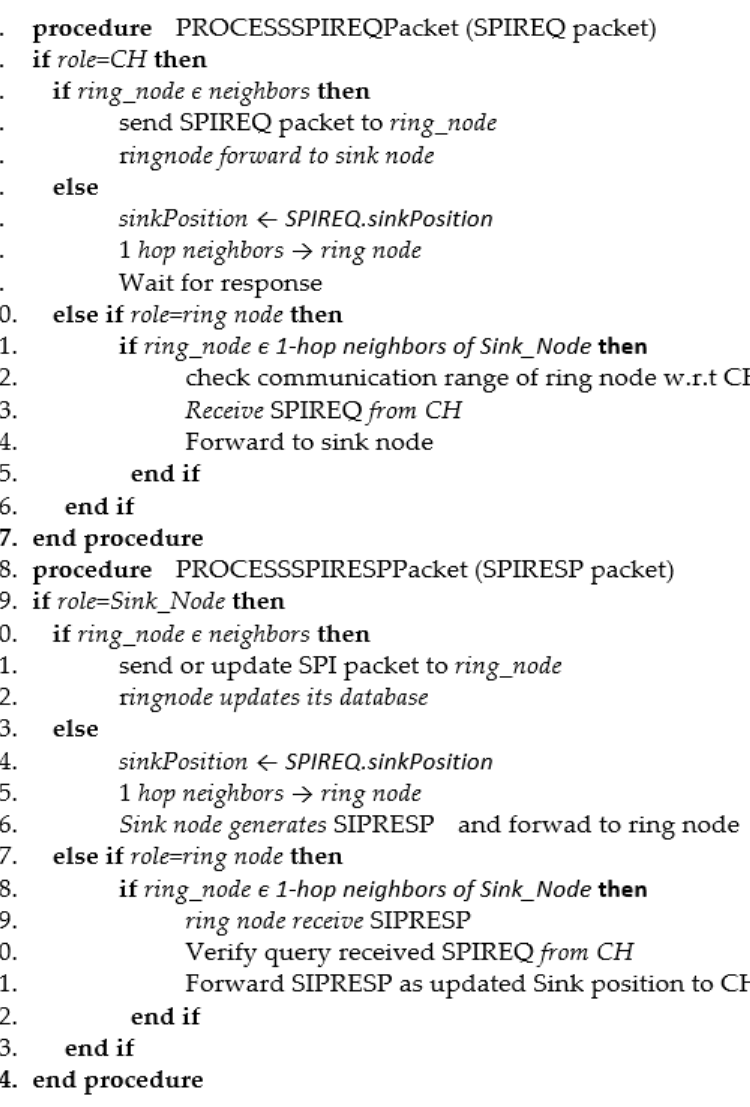
Figure 7 . Pseudo code for the procedure of the SPIREQ and SPIRESP packets. Figure 7. Pseudo code for the procedure of the SPIREQ and SPIRESP